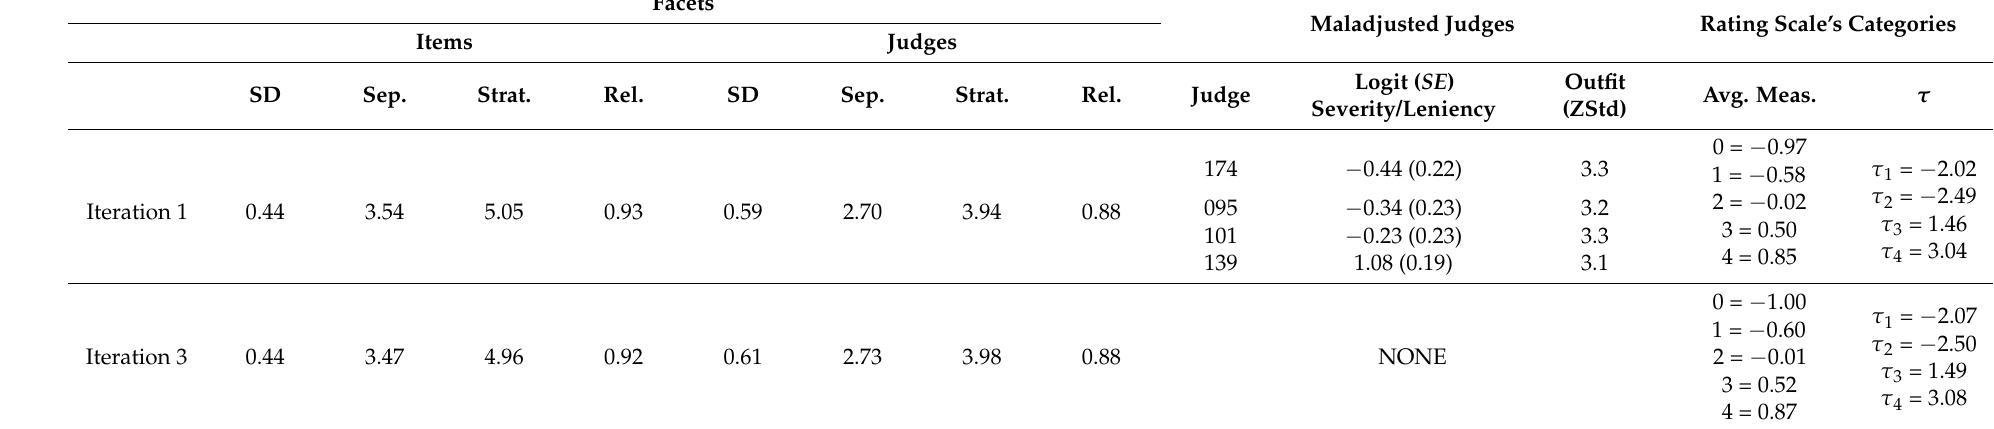
Table 7. Data fit (iterations 2 and 3).